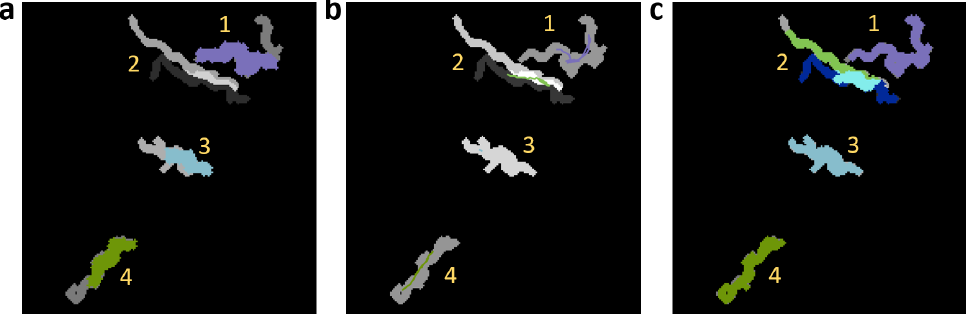
Figure 12. Comparison of trackers. Comparison of reconstruction of C. elegans bodies between labeled data (shaded in grays) and predictions obtained with different trackers (shaded in colors). ( a ) Results obtained using tierpsy-tracker [22]. ( b ) Labeled data (grays) compared with colored lines that connect centroids obtained using WF-NTP.v3 [23]. ( c ) Results obtained using model